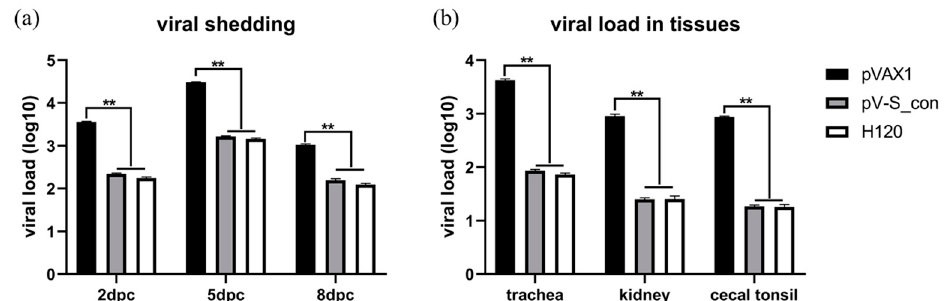
Figure 7. Viral shedding ( a ) and viral load in tissues ( b ) after M41 challenge. The formula of the standard curve is y = 37.302 − 3.155x, E = 107.5%, R 2 = 0.988. A multiple t -test was used for statistical analysis. Viral loads are shown as mean values + SEM of each group; ** p < 0.01.